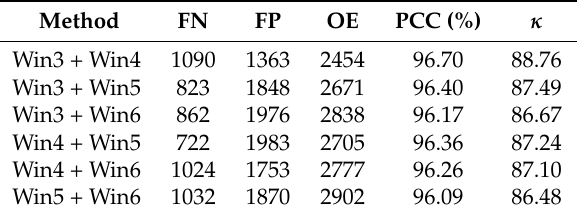
Figure 19. The wrong results on several single block size inputs of different data sets. ( a ) Farmland D data set. ( b ) Farmland C data set. ( c ) Inland water data set. ( d ) Coastline data set. Table 5. The evaluation values of different sizes of fused blocks of the Farmland D data set.